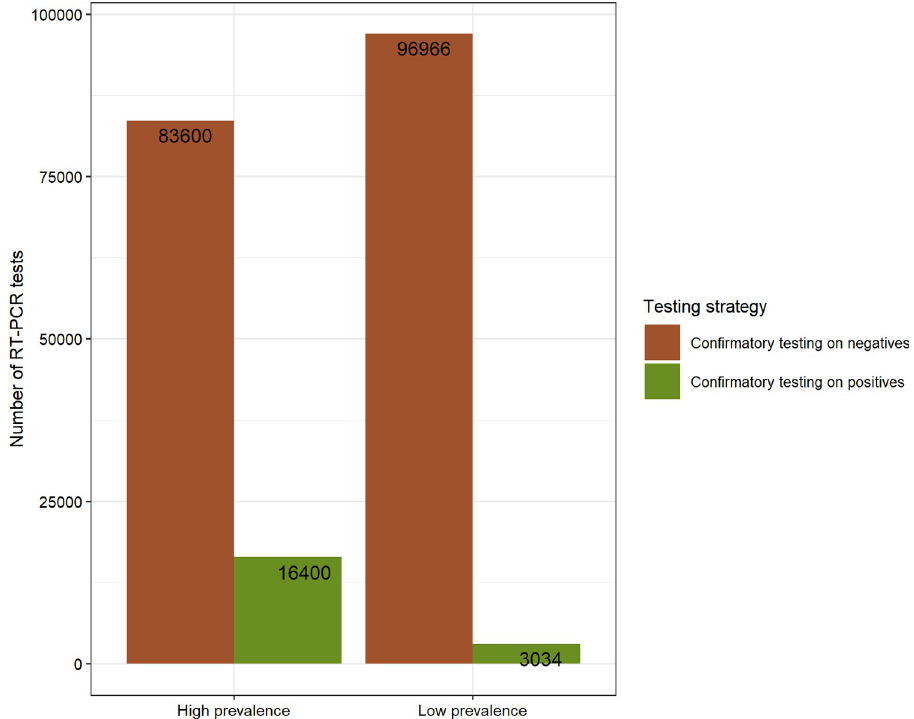
Fig 4. Number of RT-PCR tests. The required quantity of RT-PCR tests when applied as a second test in the two-test algorithm differed by testing strategy and infection prevalence. It corresponds to the population being tested (100,000) when used as a single